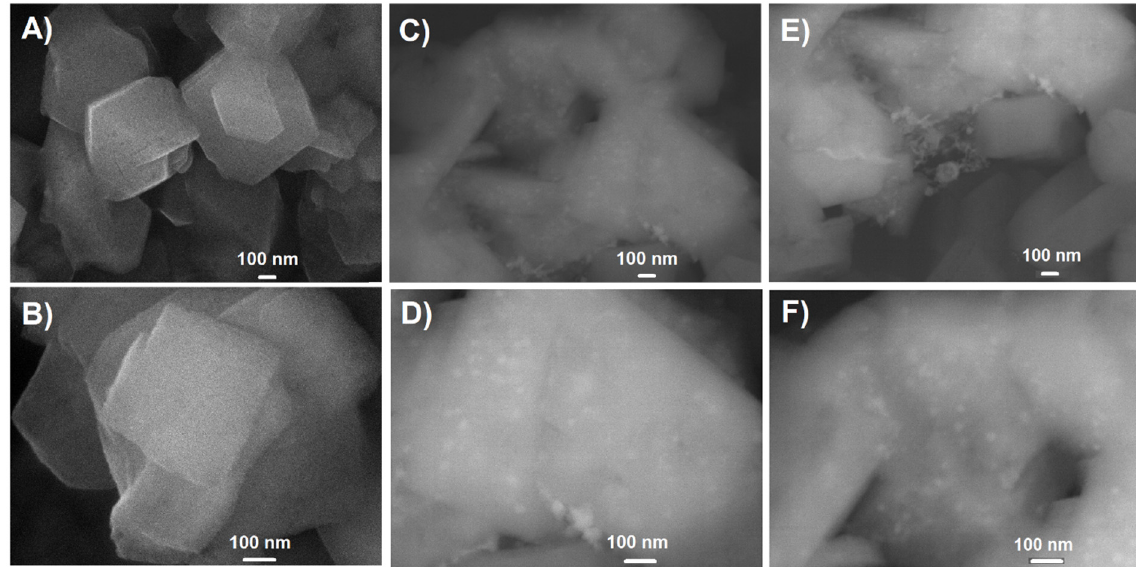
Figure 4. SEM images of the chosen samples: H-Z as a parent sample: ( A ) 50,000 x, ( B ) 100,000 x; Cu 5 H-Z sample: ( C ) 50,000 x, ( D ) 100,000 x; Cu 5 Na-Z sample: ( E ) 50,000 x, ( F ) 100,000 x.